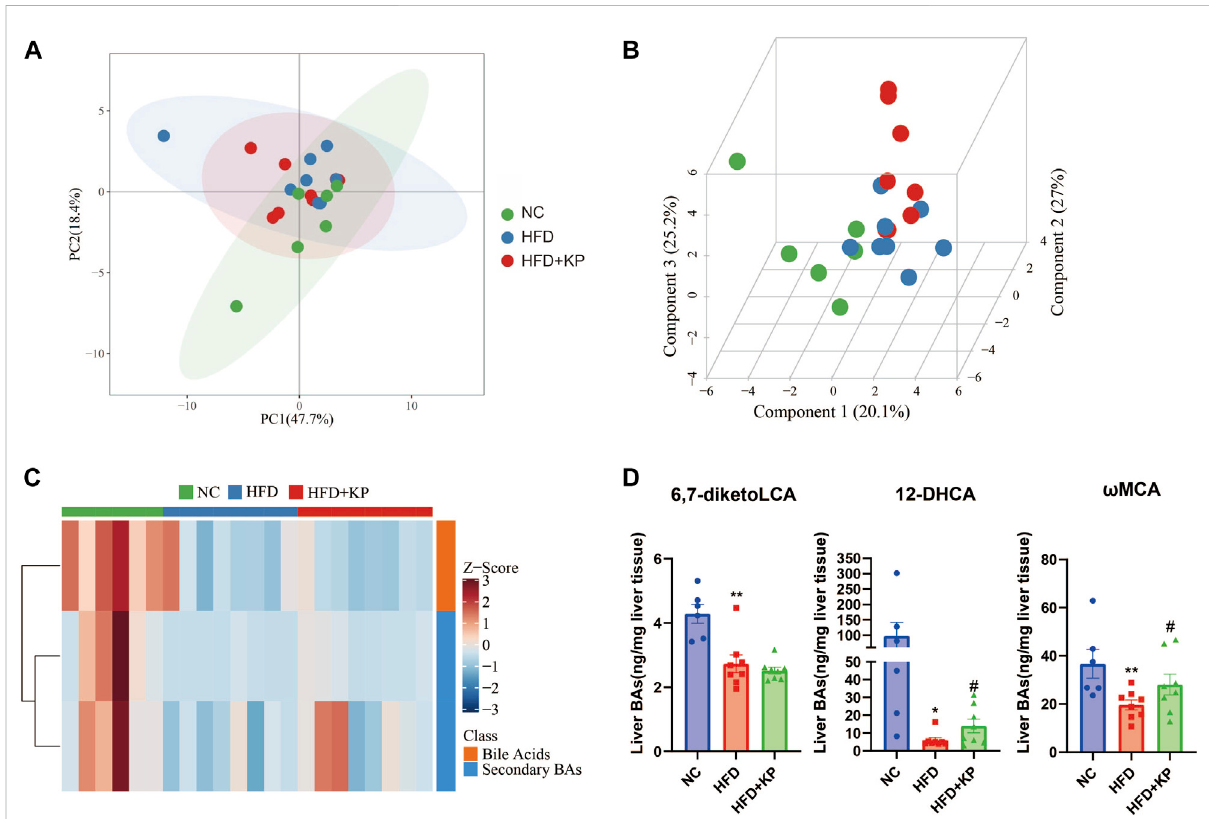
FIGURE 4 Comparison of the liver BA level and composition among three groups. (A) PCA score plots show separation among three groups based on 28 liver bile acids. (B) PLS-DA score plots show clear separation among three groups based on 28 liver bile acids. (C) Heatmap of three liver bile acid biomarkers among three groups. (D) Differential liver bile acids signi fi cantly differed among three groups. All values were expressed as mean ± SEM. * p < 0.05and** p < 0.01,whenNASHmodels(theHFDgroup)werecomparedtocontrolgroups(theNCgroup);# p < 0.05,whenNASHmodels (the HFD group) were compared to NASH models treated with kaempferol (the HFD + KP